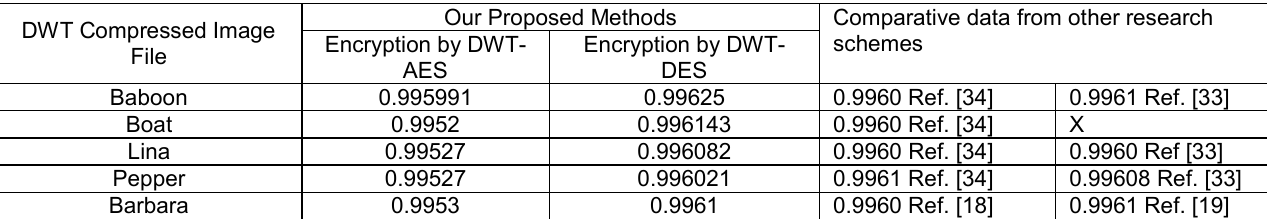
Table 8. Comparison of NPCR for different encryption techniques